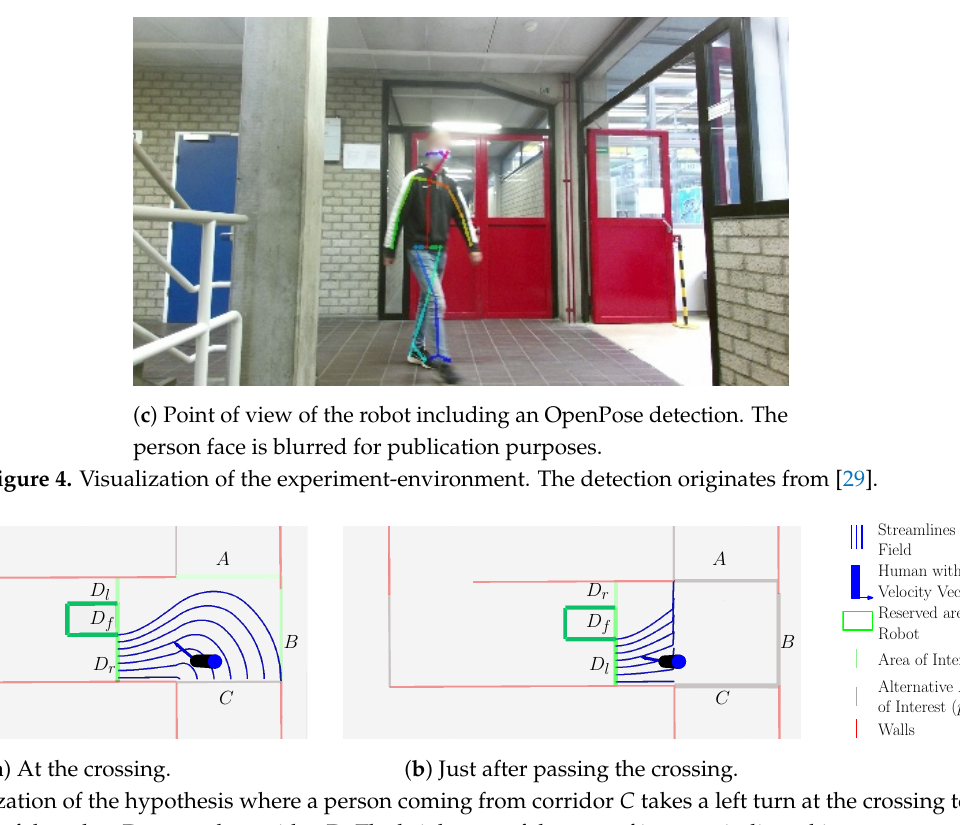
Figure 5. Visualization of the hypothesis where a person coming from corridor C takes a left turn at the crossing to move via the right side of the robot D r towards corridor D . The brightness of the area of interest, indicated in green, correlates to the probability of moving towards this area. A brighter color indicates a higher